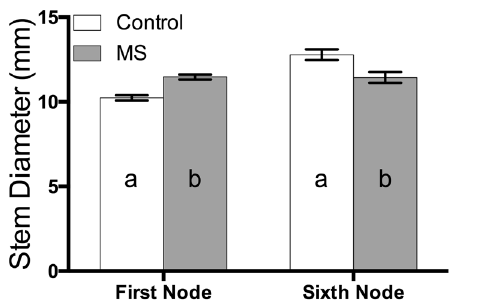
Figure 2: Relative chlorophyll levels (SPAD) in the last fully expanded leaf under control and mechanical stimulation treatments. Columns with the same letter appearing above do not differ at p≤0.05. Error bars are SEM.